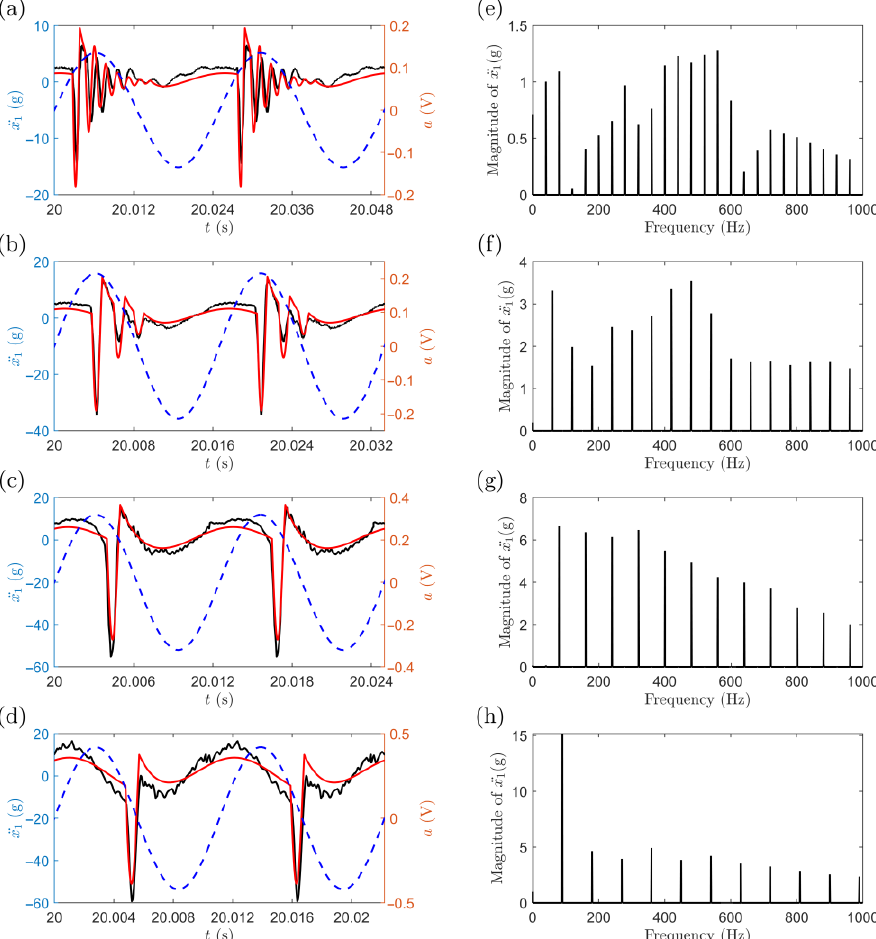
Figure 4. Time histories ( a ), ( b ), ( c ) and ( d ) and FFT ( e ), ( f ), ( g ) and ( h ) of the acceleration of the indenter when the excitation frequencies are 40 Hz ( first row ), 60 Hz ( second row ), 80 Hz ( third row ) and 90 Hz ( last row ) for the sandstone case. The black line represents experimental results, the red line represents simulation results, and the blue line is the input excitation voltage.